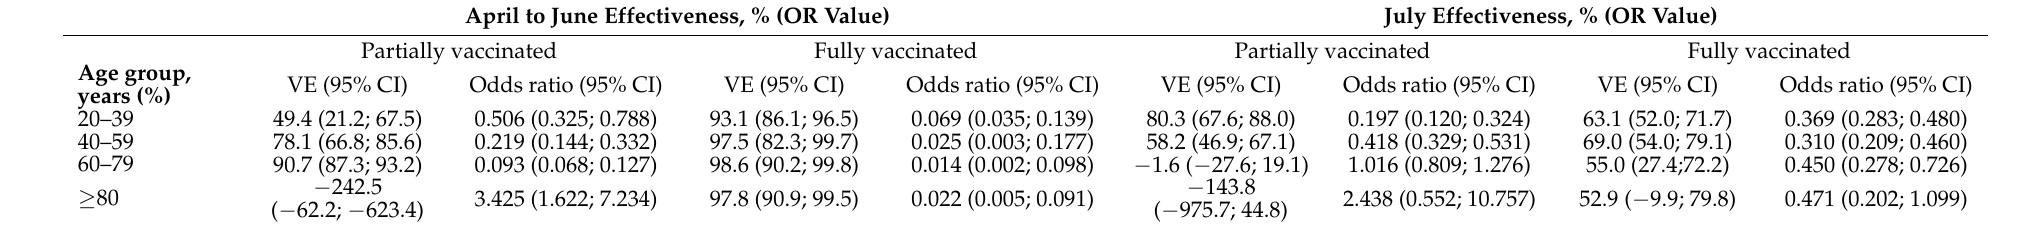
Table 2. Reduction in COVID-19 vaccine effectiveness against SARS-CoV-2 infection according to age, sex, and symptoms. April to June Effectiveness, % (OR